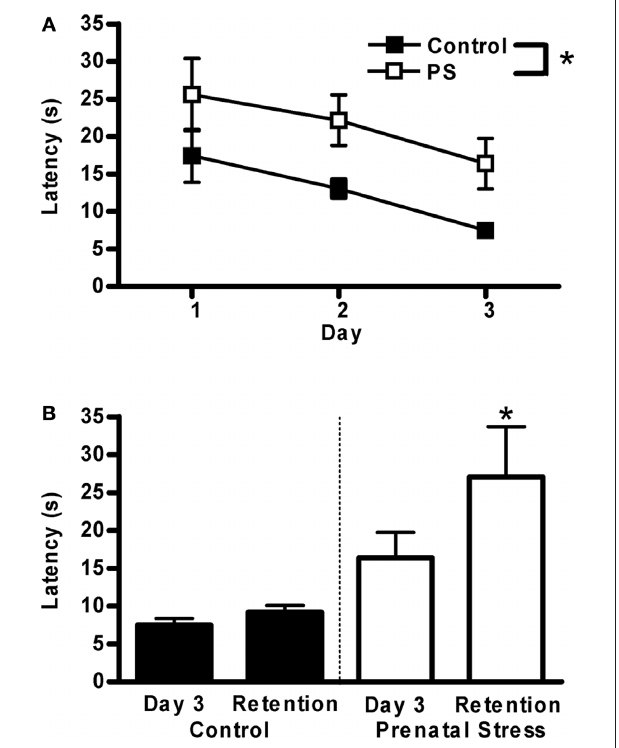
Figure 3 | Morris water maze. (A) Prenatally stressed (PS) male rats took significantly longer to locate a hidden platform over 3 days of training (* p < 0.04). (B) On a memory retention test 4 days following training, control rats maintained their level of performance, whereas PS rats did not (retention > day 3 training latency, * p = 0.05). Values are group mean ±